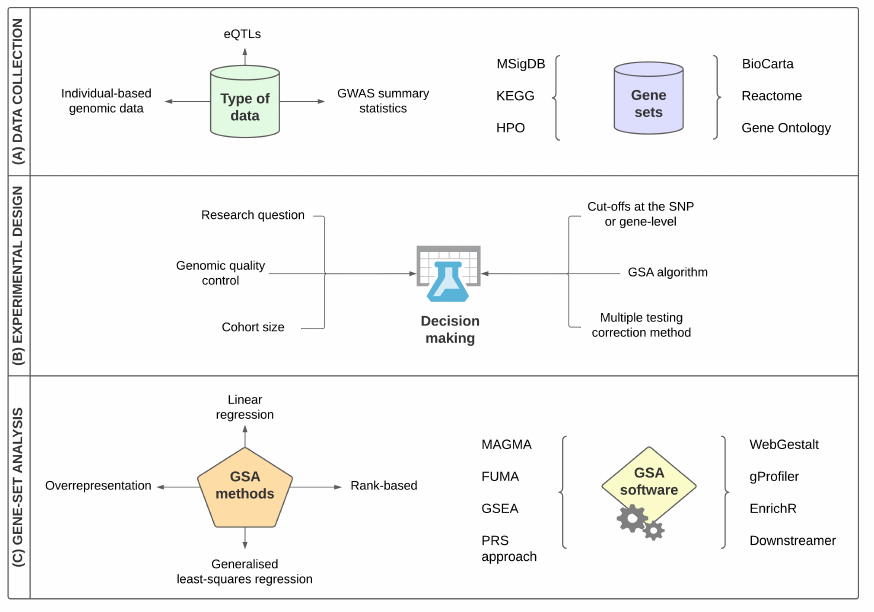
Figure 1. Main strategies and features of the collected ALS gene-set analysis studies. The main GSA design characteristics of the collected studies include ( A ) Collection of the input data that may include individual-based genomic data, summary statistics and any other type of biological data, e.g., expression Quantitative Trait Loci (eQTLs) as well as the collection of gene sets from a variety of annotation databases such as the Gene Ontology, Kyoto Encyclopedia of Genes and Genomes (KEGG) and Molecular Signatures Database (MSigDB); ( B ) decision-making for a variety of steps of the main experimental design, including among others, defining the main research question of the study, following a genomic quality control analysis if individual-based genomic data are analysed, and which gene-set analysis method/algorithm/software and multiple testing correction strategies are more appropriate for the study and ( C ) gene-set analysis main methods and software of the collected